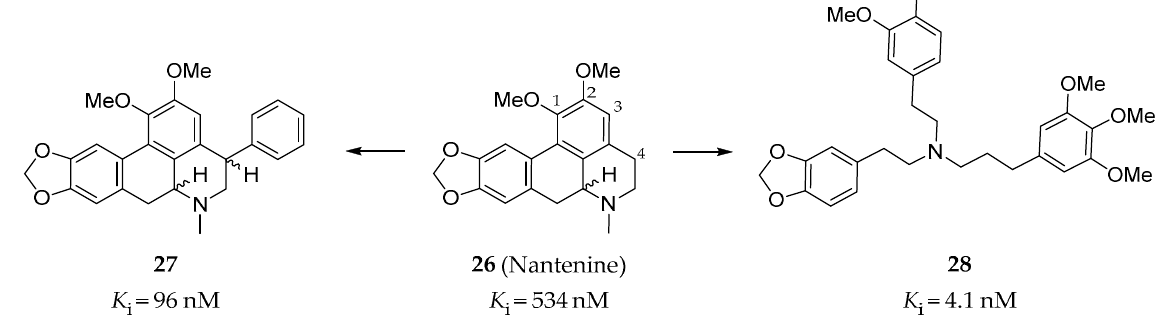
Figure 7. Representative chromone derivatives as non-nitrogenous 5-HT 2B R antagonists [138–140].